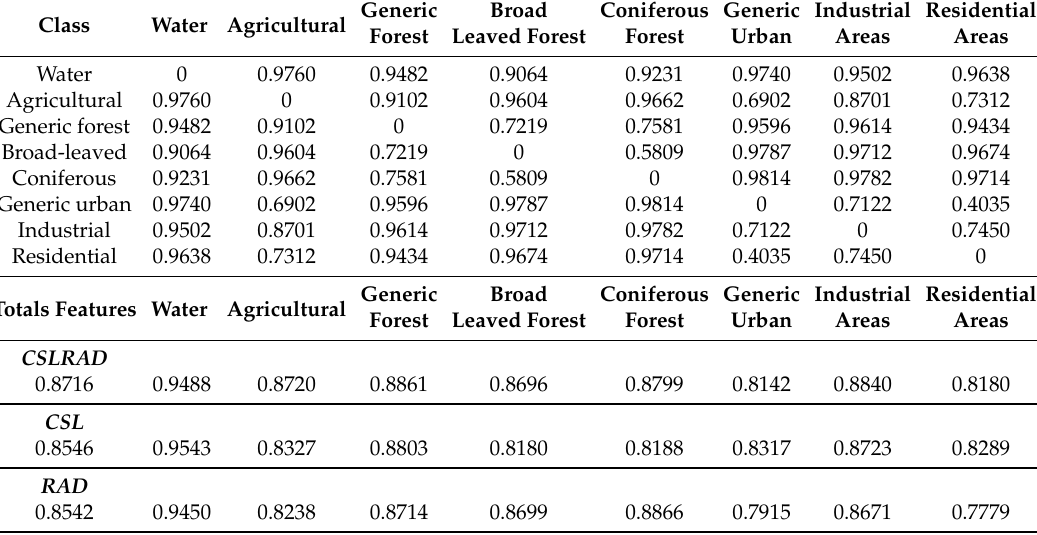
Table 1. Class separability by the histogram distance index (HDI) of the Φ E on data sequences generated from Spot 5 satellite data. Top: mutual class separability based on joint sequencing of morphological multiscale (characteristic saliency leveling (CSL)) and radiometric image descriptors. Bottom: average class separability for different sequencing options. CSLRAD joint morphological and